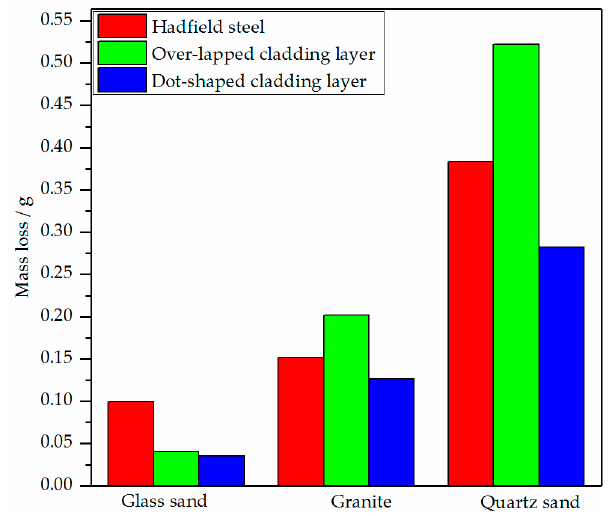
Figure 8. Mass loss of the specimens.